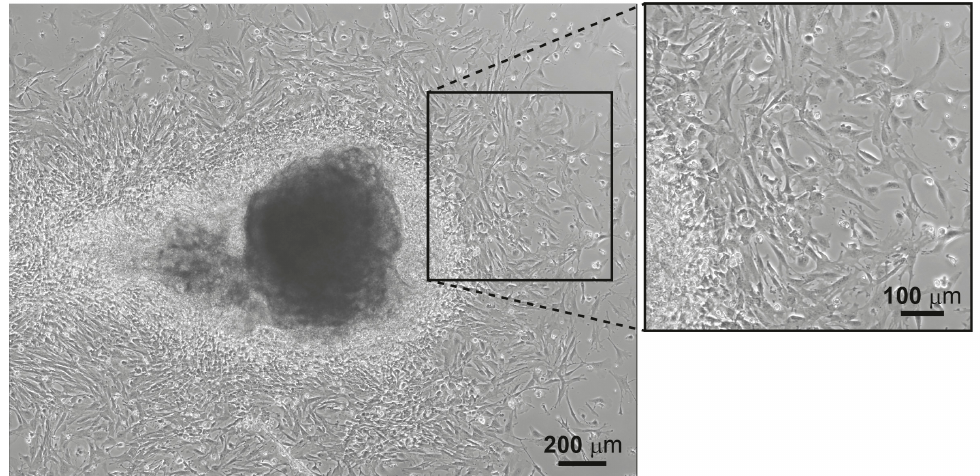
Figure 3. Light microscopy image of lung fibroblasts crawling-out from lung tissue pieces ( left ) and higher magnification image ( right ). Scale bars: 200 and 100 µm for the magnified area.